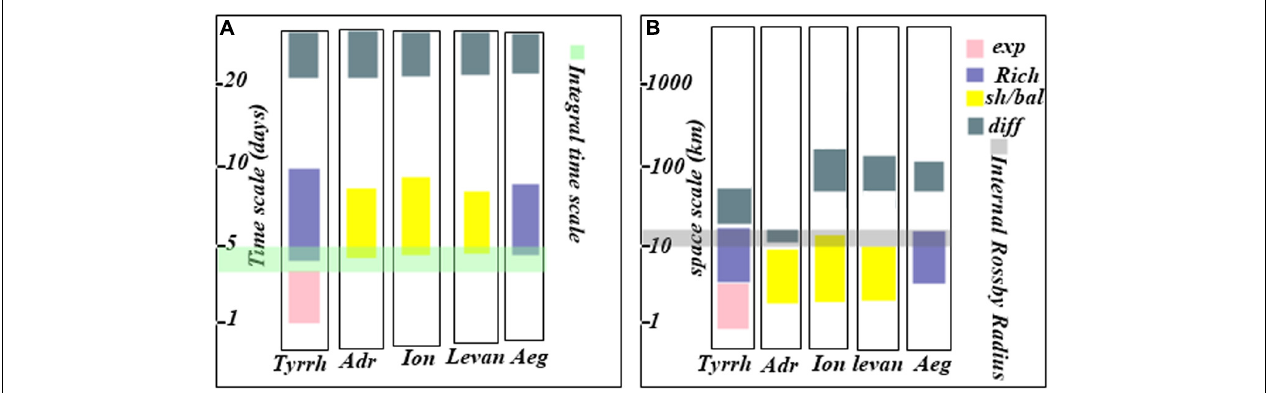
FIGURE 13 | Occurrence of different relative dispersion regimes in the Tyrrhenian, the Adriatic, the Ionian, the Levantine and the Aegean sub-basins as a function of the time scale (A) and space scale (B) . The colors are referred to relative dispersion regimes as follow: pink = exponential regime, blue-gray = Richardson regime, yellow = shear/ballistic regime and pale-blue = diffusive regime. The light green and gray colors indicate the integral time scale and the internal Rossby radius of deformation,